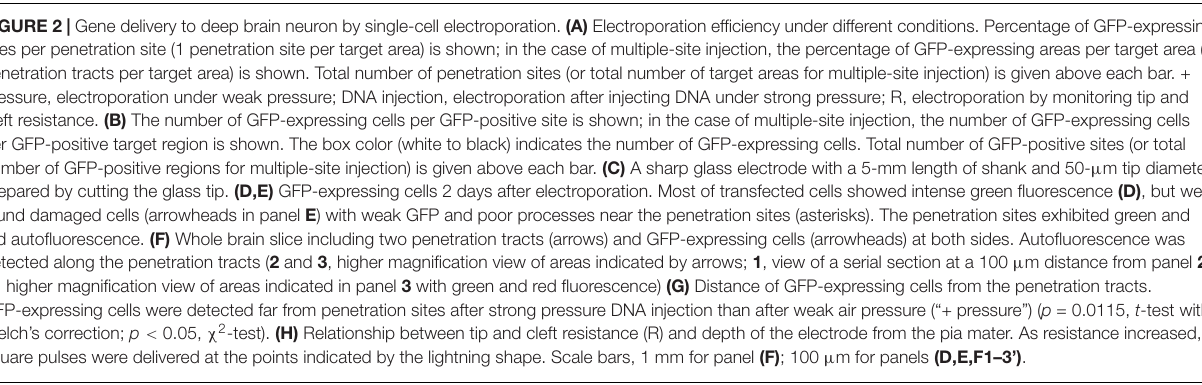
FIGURE 2 | Gene delivery to deep brain neuron by single-cell electroporation. (A) Electroporation efficiency under different conditions. Percentage of GFP-expressing sites per penetration site (1 penetration site per target area) is shown; in the case of multiple-site injection, the percentage of GFP-expressing areas per target area (3 penetration tracts per target area) is shown. Total number of penetration sites (or total number of target areas for multiple-site injection) is given above each bar. + pressure, electroporation under weak pressure; DNA injection, electroporation after injecting DNA under strong pressure; R, electroporation by monitoring tip and cleft resistance. (B) The number of GFP-expressing cells per GFP-positive site is shown; in the case of multiple-site injection, the number of GFP-expressing cells per GFP-positive target region is shown. The box color (white to black) indicates the number of GFP-expressing cells. Total number of GFP-positive sites (or total number of GFP-positive regions for multiple-site injection) is given above each bar. (C) A sharp glass electrode with a 5-mm length of shank and 50- µ m tip diameter prepared by cutting the glass tip. (D,E) GFP-expressing cells 2 days after electroporation. Most of transfected cells showed intense green fluorescence (D) , but we found damaged cells (arrowheads in panel E ) with weak GFP and poor processes near the penetration sites (asterisks). The penetration sites exhibited green and red autofluorescence. (F) Whole brain slice including two penetration tracts (arrows) and GFP-expressing cells (arrowheads) at both sides. Autofluorescence was detected along the penetration tracts ( 2 and 3 , higher magnification view of areas indicated by arrows; 1 , view of a serial section at a 100 µ m distance from panel 2 , 3’ , higher magnification view of areas indicated in panel 3 with green and red fluorescence) (G) Distance of GFP-expressing cells from the penetration tracts. GFP-expressing cells were detected far from penetration sites after strong pressure DNA injection than after weak air pressure (“+ pressure”) ( p = 0.0115, t -test with Welch’s correction; p < 0.05, χ 2 -test). (H) Relationship between tip and cleft resistance (R) and depth of the electrode from the pia mater. As resistance increased, square pulses were delivered at the points indicated by the lightning shape. Scale bars, 1 mm for panel (F) ; 100 µ m for panels (D,E,F1–3’)